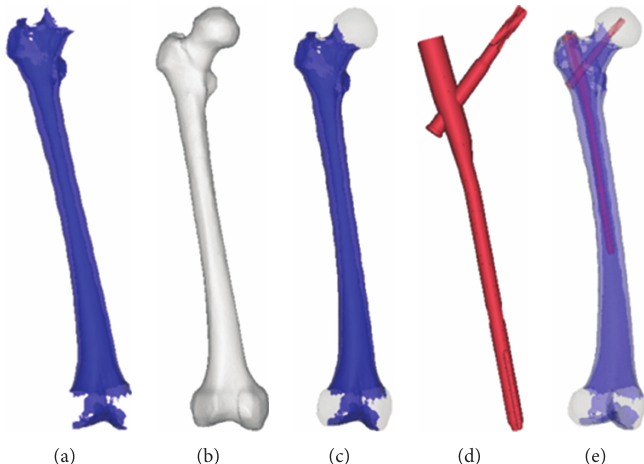
Figure 1: The femur and implant models were reconstructed with software and assembled according to the paper guidelines. (a) The femoral cortex model; (b) the intact femur model. (c) The femoral cortex differentiated from the intact femur model. (d) The PFNA-II model; (e) the implant assembled with the femoral